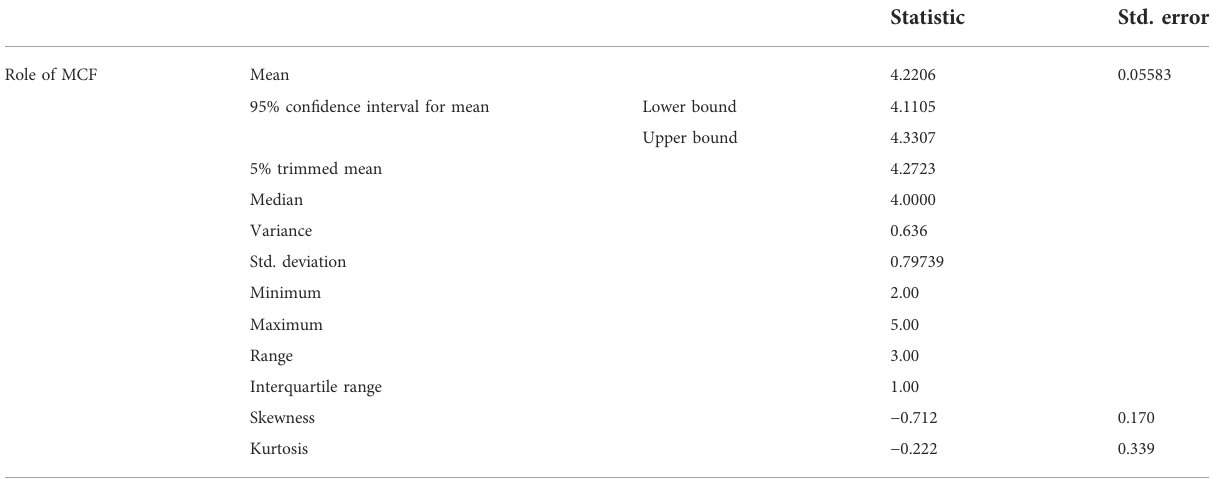
TABLE 2 Descriptive study of the role of the MCF.